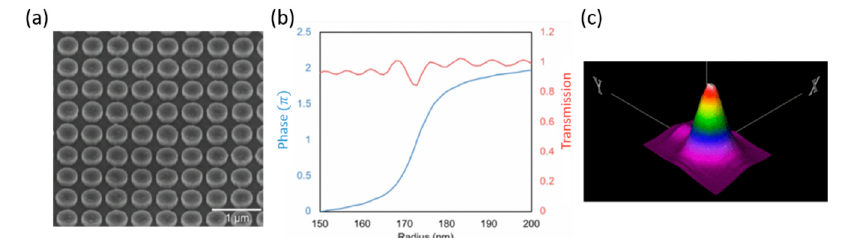
Figure 14. Metalens-based confocal microscope system. ( a ) TiO 2 nanoresonator array. ( b ) Phase and transmission vs. nanodisc radius by FDTD simulation. ( c ) a 3D intensity laser-focused spot profile. (Reproduced from [93] with permission.)